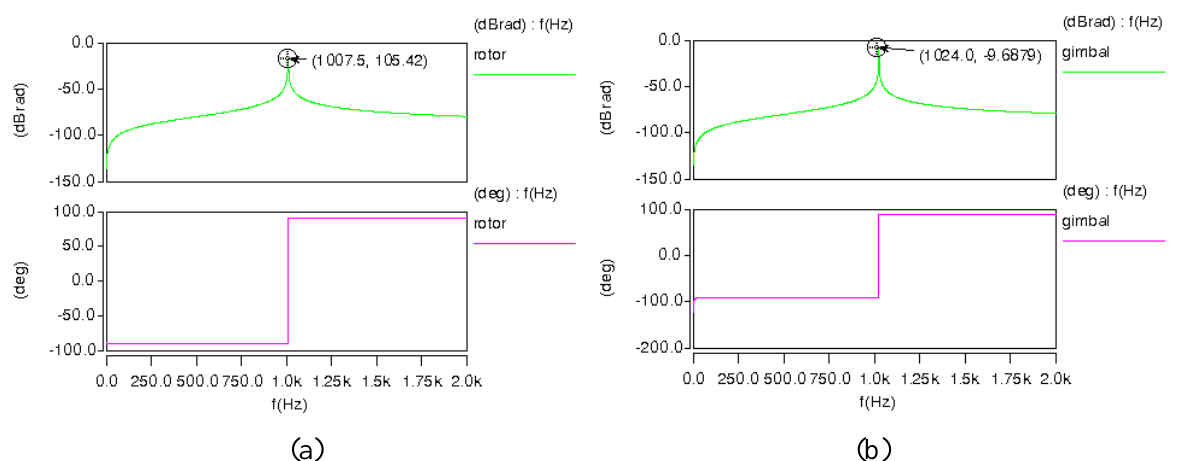
Figure 6. (a) AC analysis results of the rotor. (b) AC analysis results of the